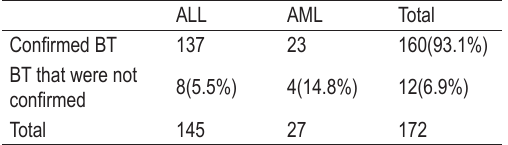
TABLE 3. Points precentage of con fi rmed blood types ac-